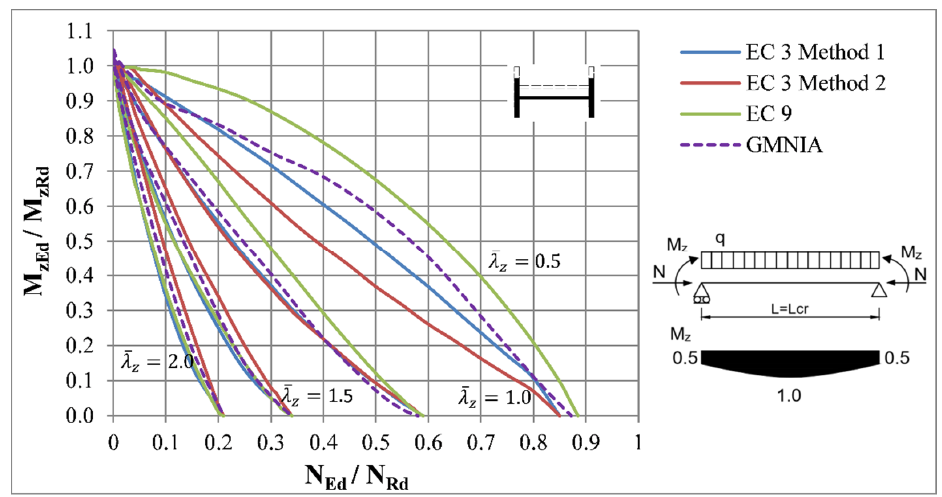
Figure 30. Interaction curves for weak axis flexural buckling of beam-columns with IPE 100 cross-section.